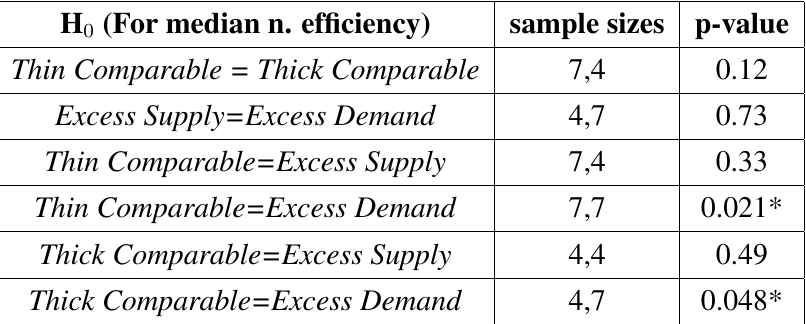
Table 5. Testing equality of normalized efficiency in the last five